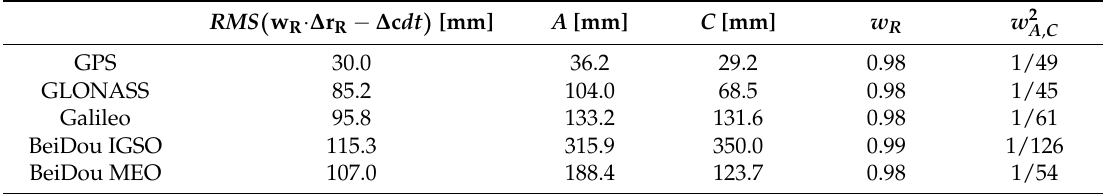
Figure 3. Signal-in-space ranging errors (SISRE) values for GNSS satellites calculated individually (horizontal bars) and one general value for a particular system (horizontal black lines). Table 3. Values used in SISRE computation.